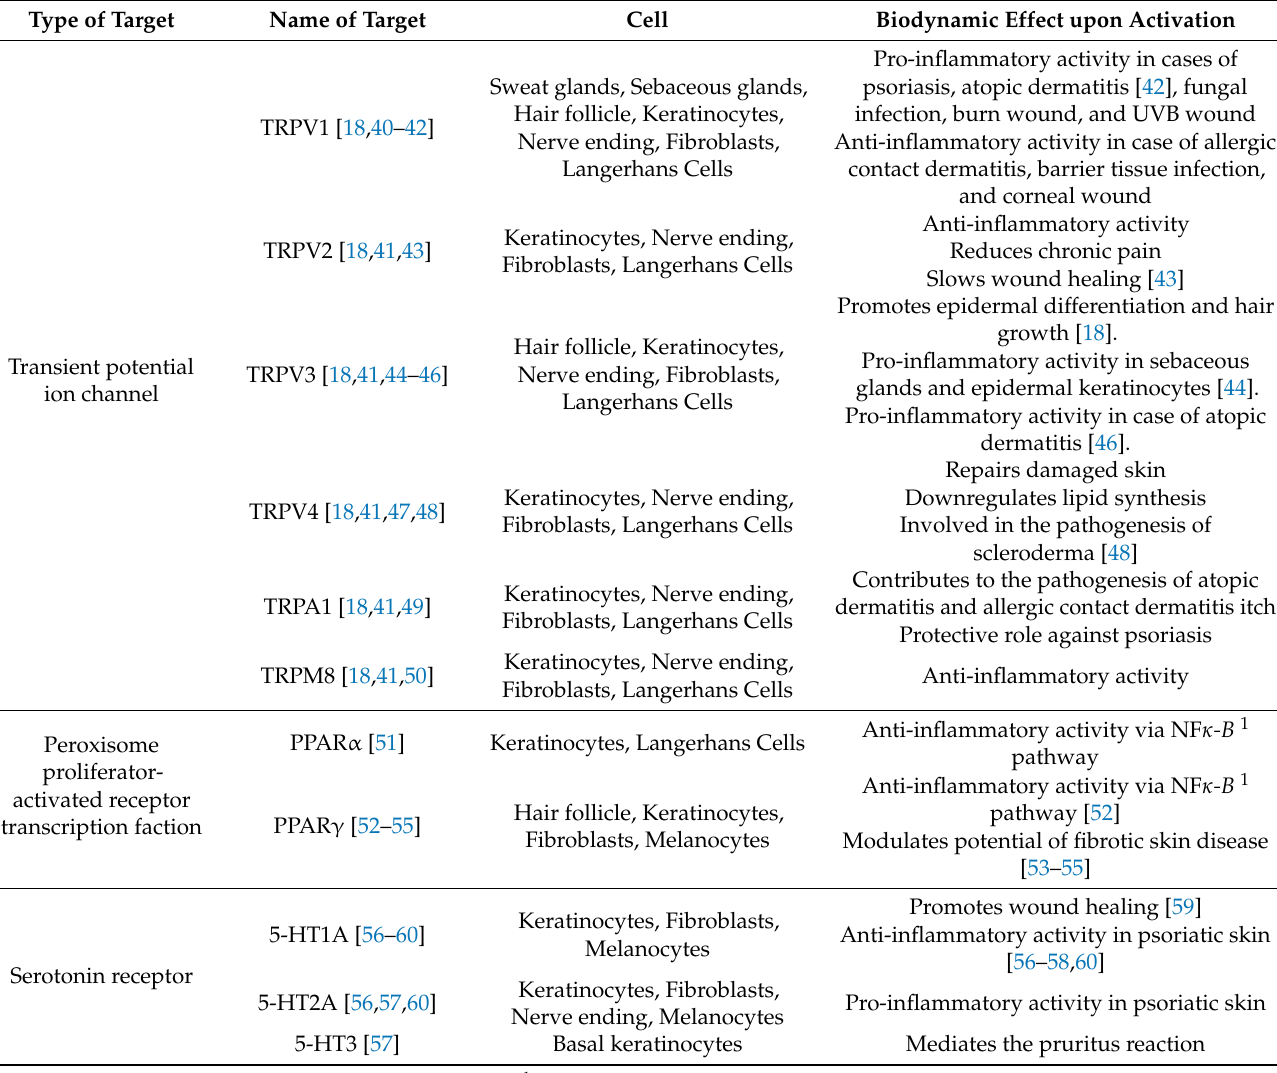
Table 1. Location and biodynamic effects of main secondary targets of cannabinoid ligands. Type of